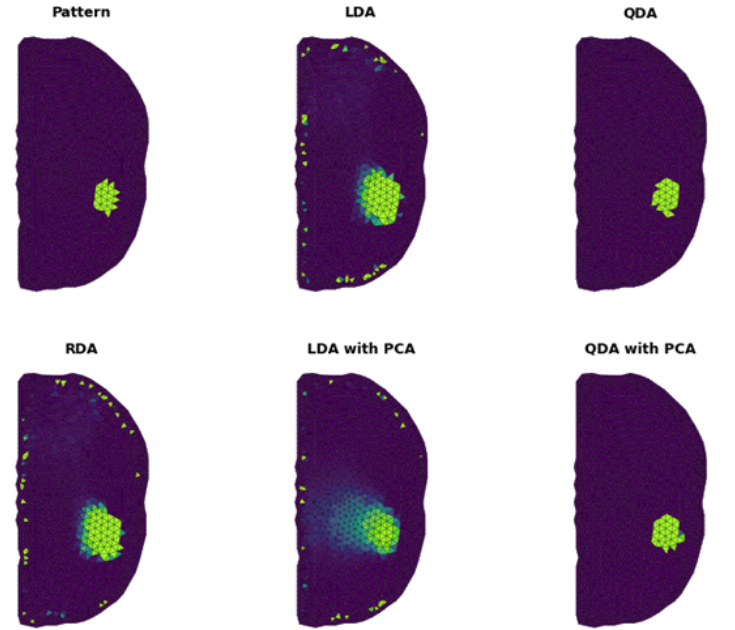
Figure 9. The top left panel shows the shape of the inclusion. The other panels show the results obtained by the discriminant method with/without dimensionality reduction.